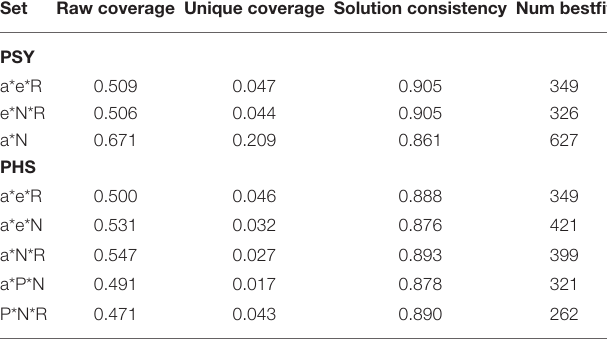
TABLE 4 | Dimensionality reduction for common sets of PSY and PHS.